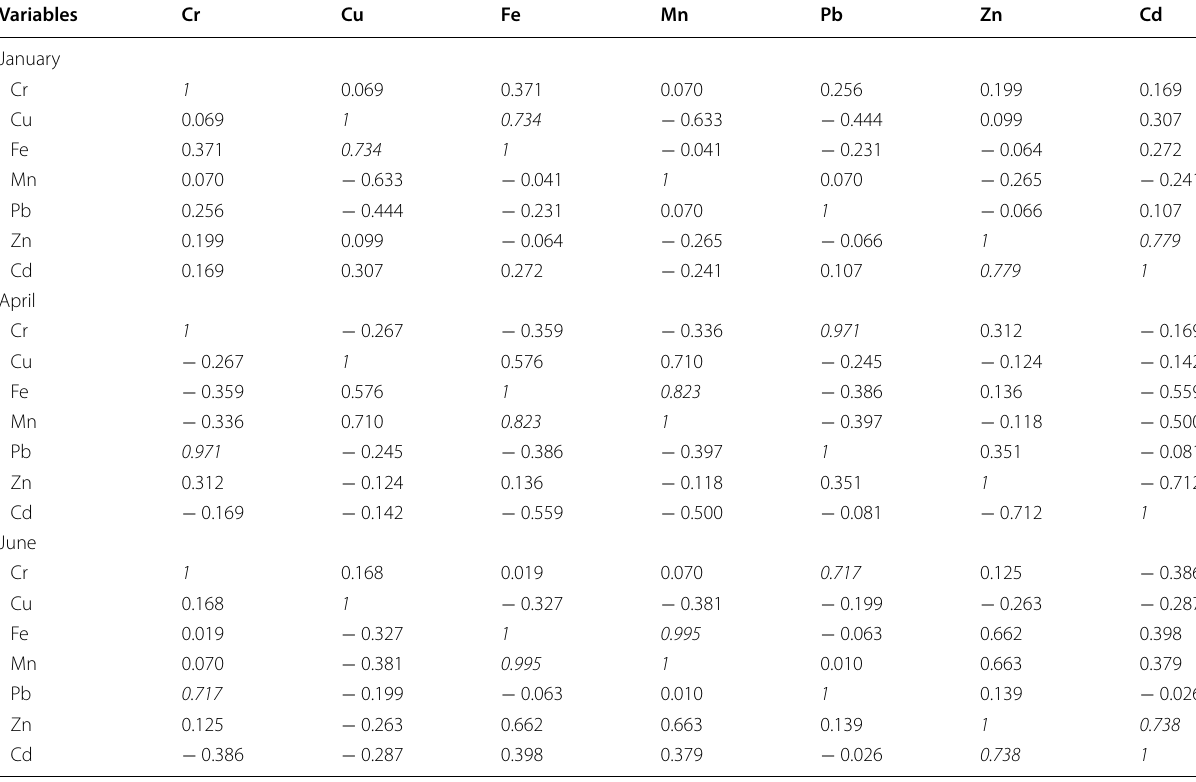
Values in italic have significance correlation